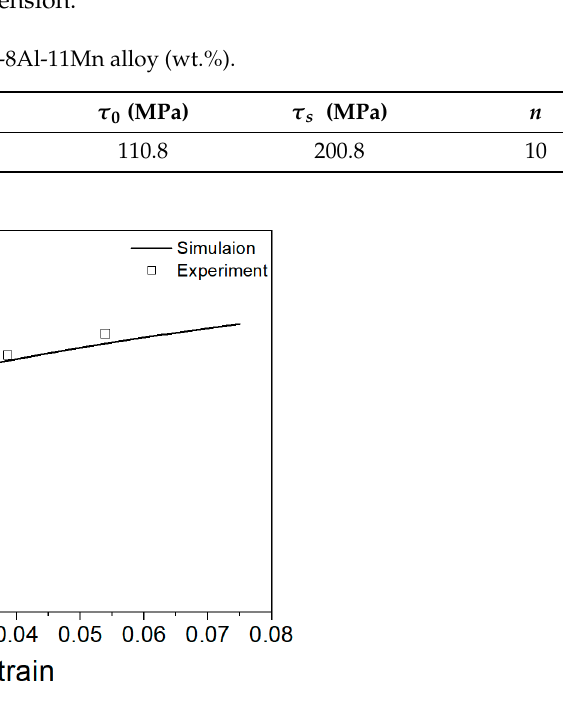
Figure 3. Stress-strain curves under tension (squares—experimental results, line—simulation results). Based on the material parameters in Table 2, single-grain (SG), columnar-grain (CG), bamboo-like-grain (BLG), and equiaxed-grain (EG) models were established, as shown in Figure 4. The geometric dimensions of each model were 30 mm (x) × 50 mm (y) × 2 mm (z) for single grains; 10 mm (x) × 50 mm (y) × 2 mm (z) for columnar grains and bamboo-like grains; and 40 mm (x) × 40 mm (y) × 2 mm (z) for equiaxed grains. The single-grain